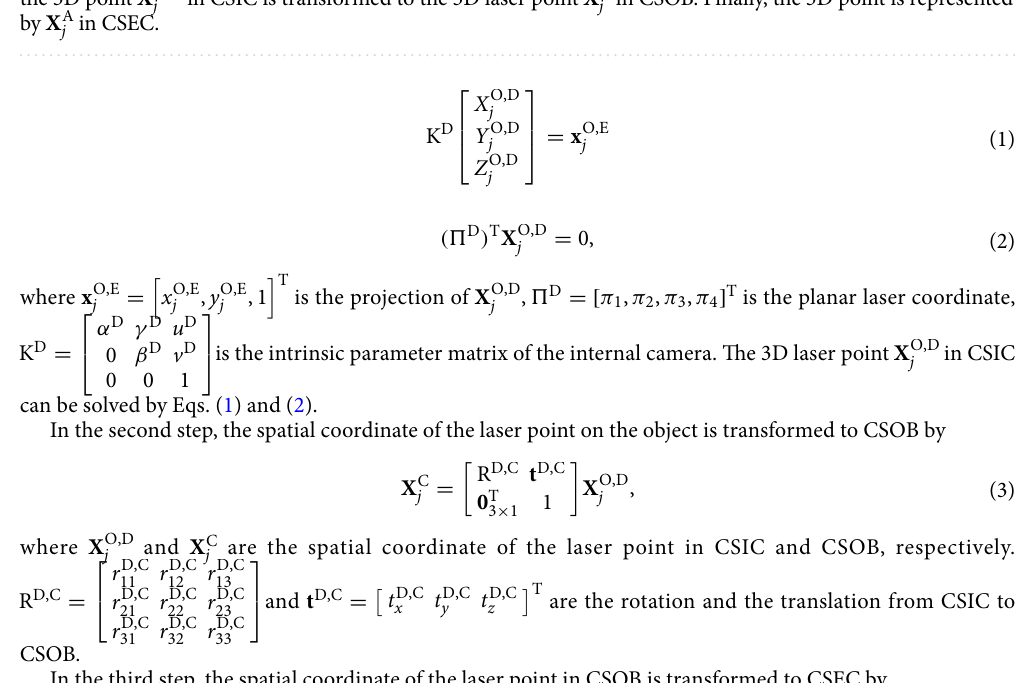
O,D j in CSIC. Then